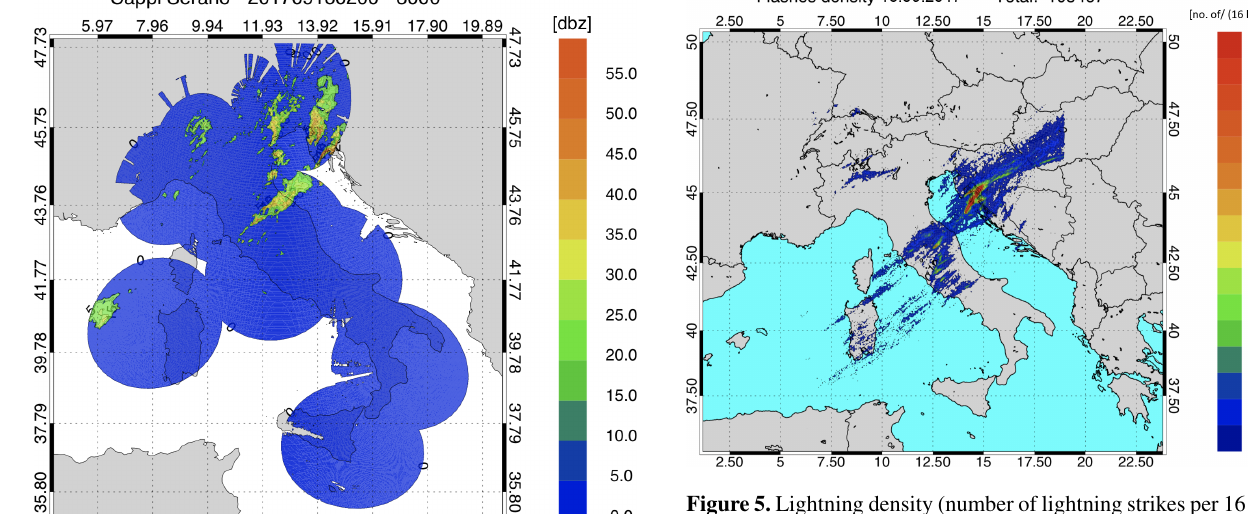
Figure 5. Lightning density (number of lightning strikes per 16km 2 for the whole day) recorded on 16 September 2017. The total num- ber of flashes is shown in the